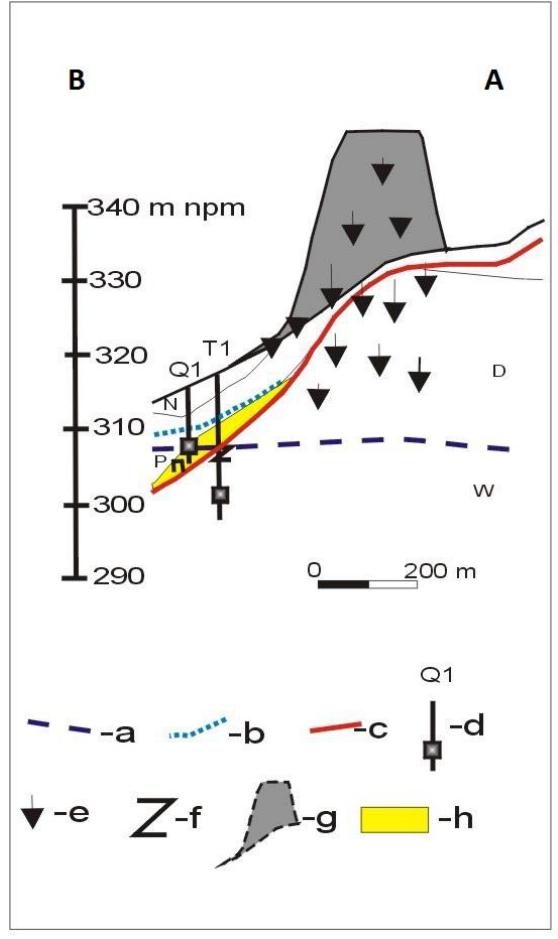
Fig. 2. Hydrogeological cross section N-S through the area of the metallurgical Lipówka landfill site (a) groundwater table in the Triassic sediments; (b) groundwater table in the Quaternary sediments; (c) stratigraphic boundary; (d) piezometer; (e) direction of seepage from the landfill; (f) confined table; (g) the Lipówka landfill; (h) poorly permeable Quaternary sediments; (w) limestone; (D) dolomites; (P) sands, (Π) dust; (N)